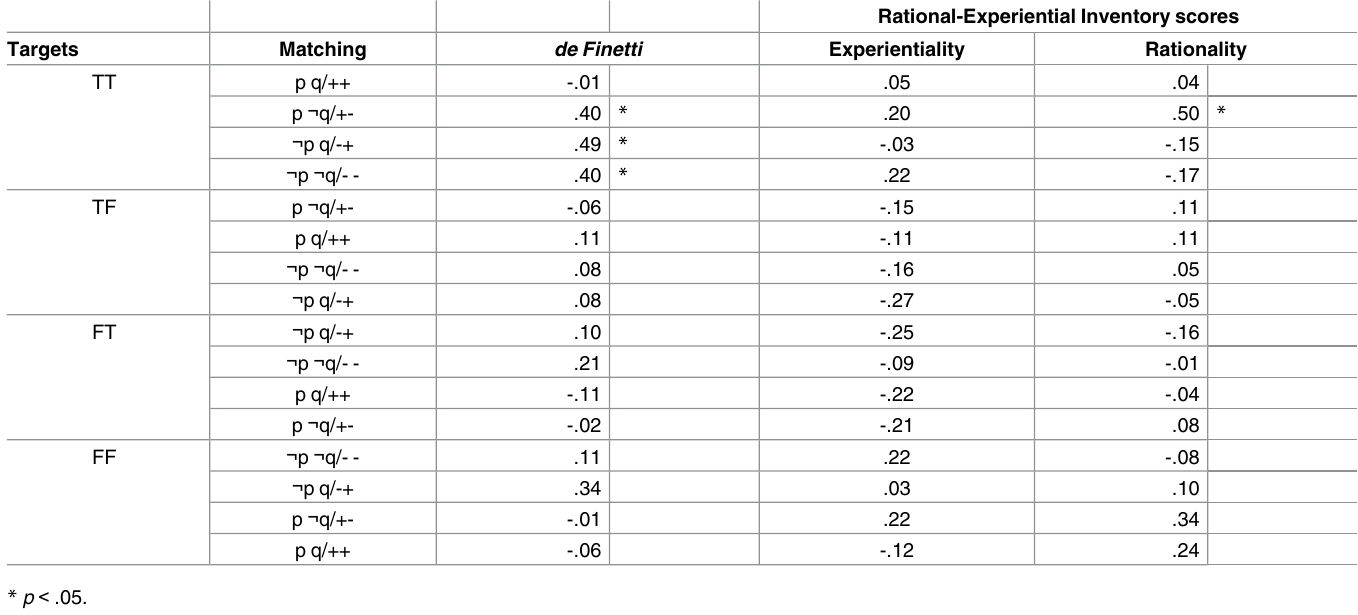
Table 5. Correlations Between the Number of De Finetti Table Responses in the Truth Table Task, Rational-Experiential Inventory Scores, and Lik- ing Ratings in Experiment 2.